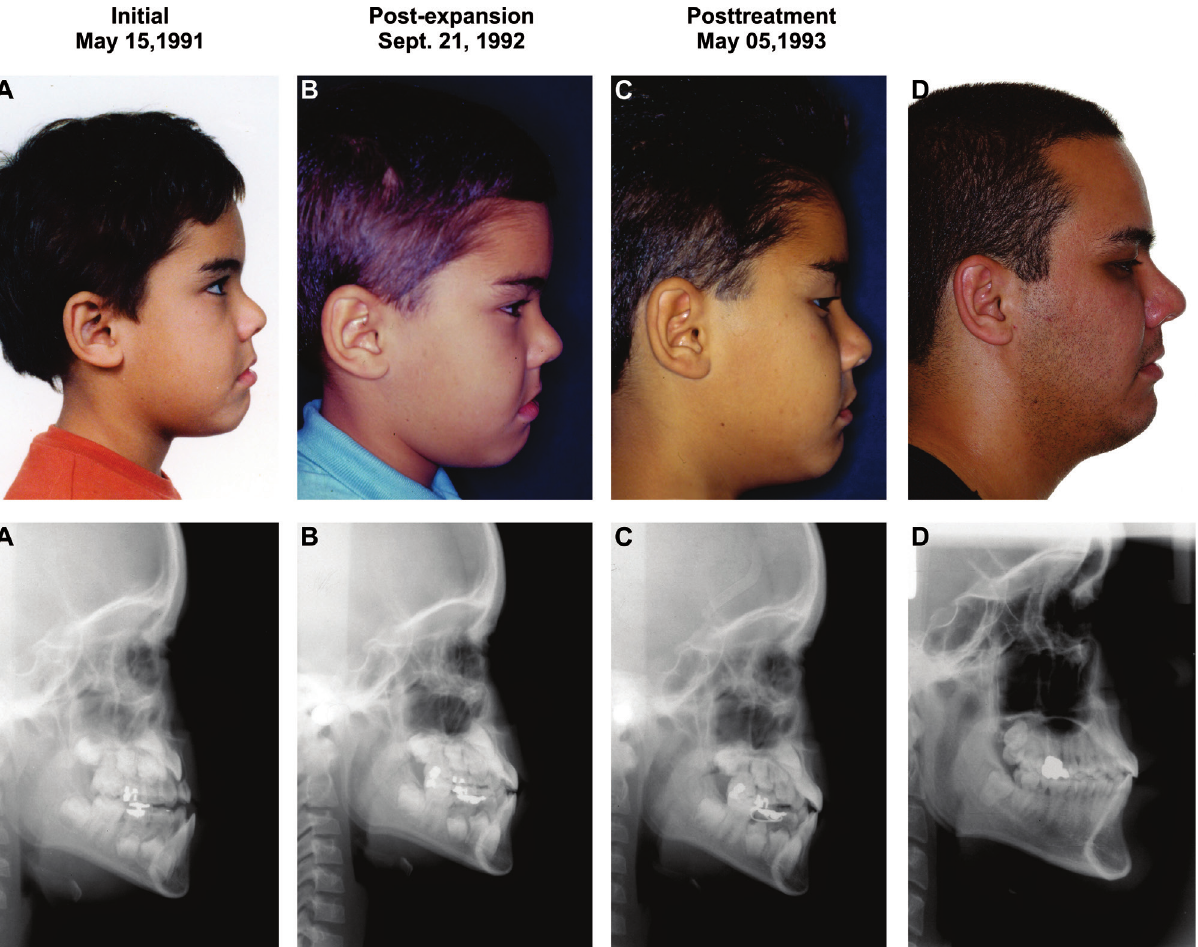
Figure 9- Photographs and lateral radiographs. Parents authorized the publication of these